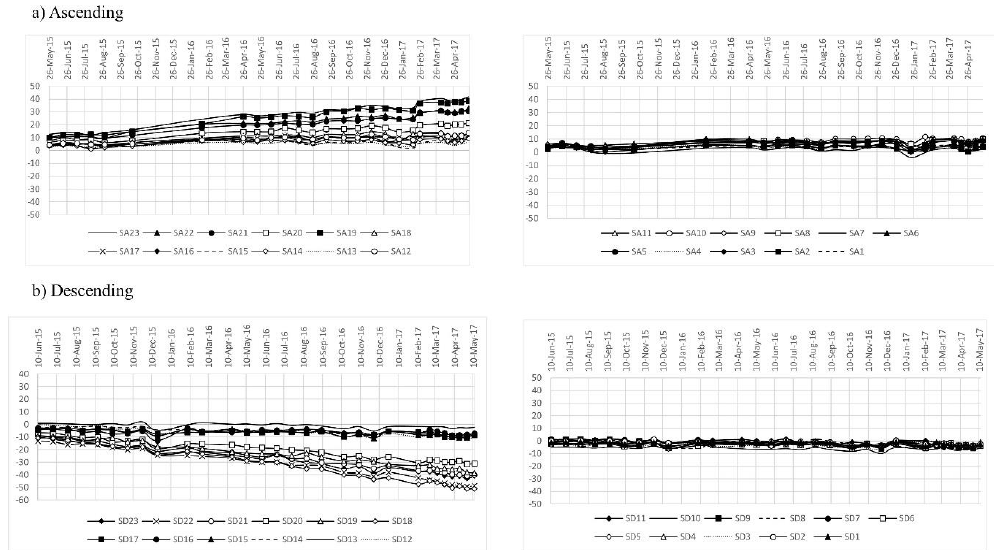
Figure 13. Cumulative 2-year LOS displacements for the South landslide for ( a ) Ascending and ( b ) Descending